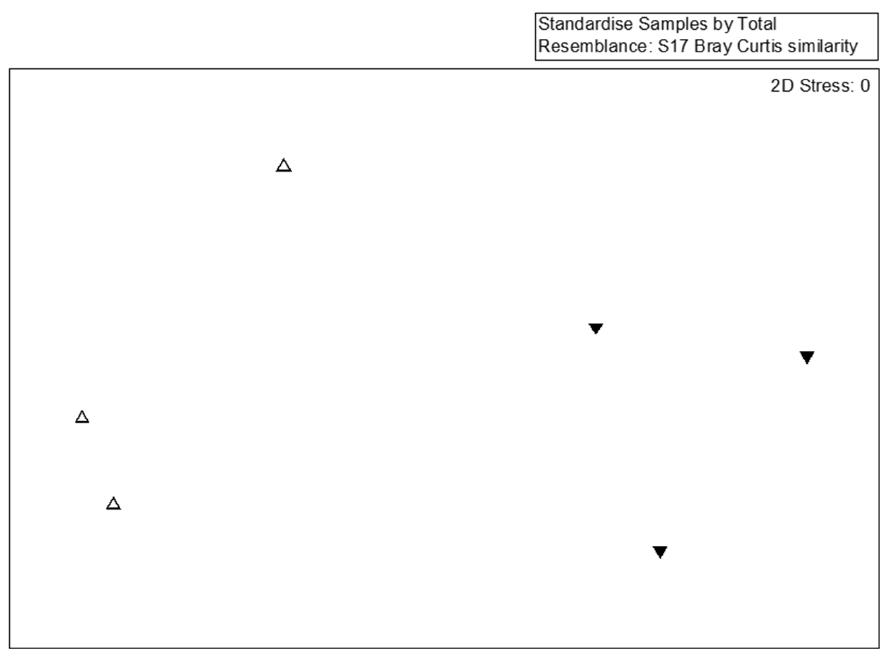
Figure 2. Multidimensional scaling of the bacterial community at the species lever from six compost samples. Bacterial taxa with relative abundances >0.1% in at least one sample were considered. Symbols indicate different treatments: triangle, spent mushroom substrate with soy wastes; inverted triangle, spent mushroom substrate with swine and poultry manure.